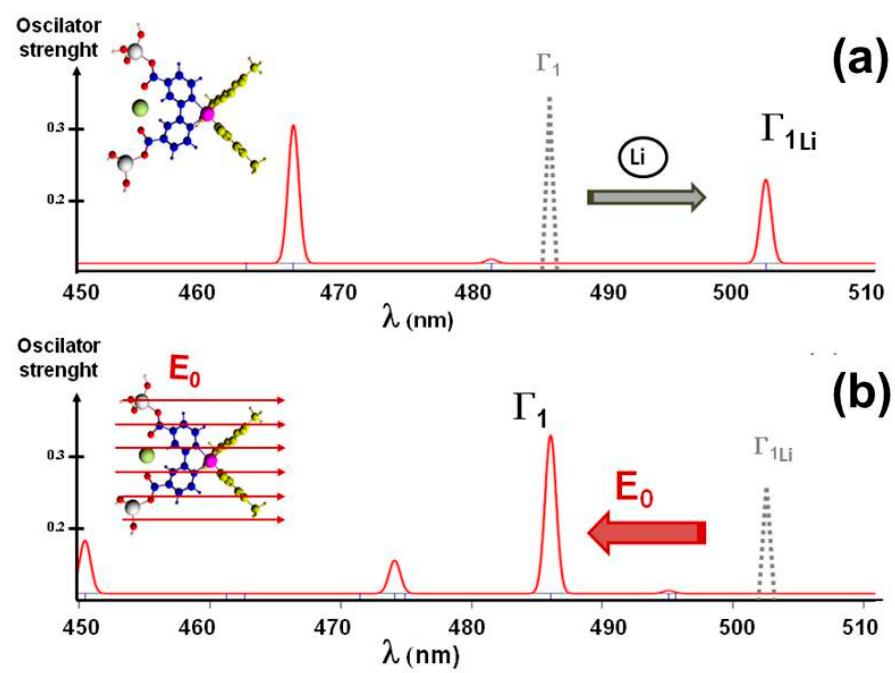
Figure 34. ( a ) Stark effect caused by Li + on the Γ 1 transition. ( b ) Annihilation of the Stark effect by an external potential of E0.